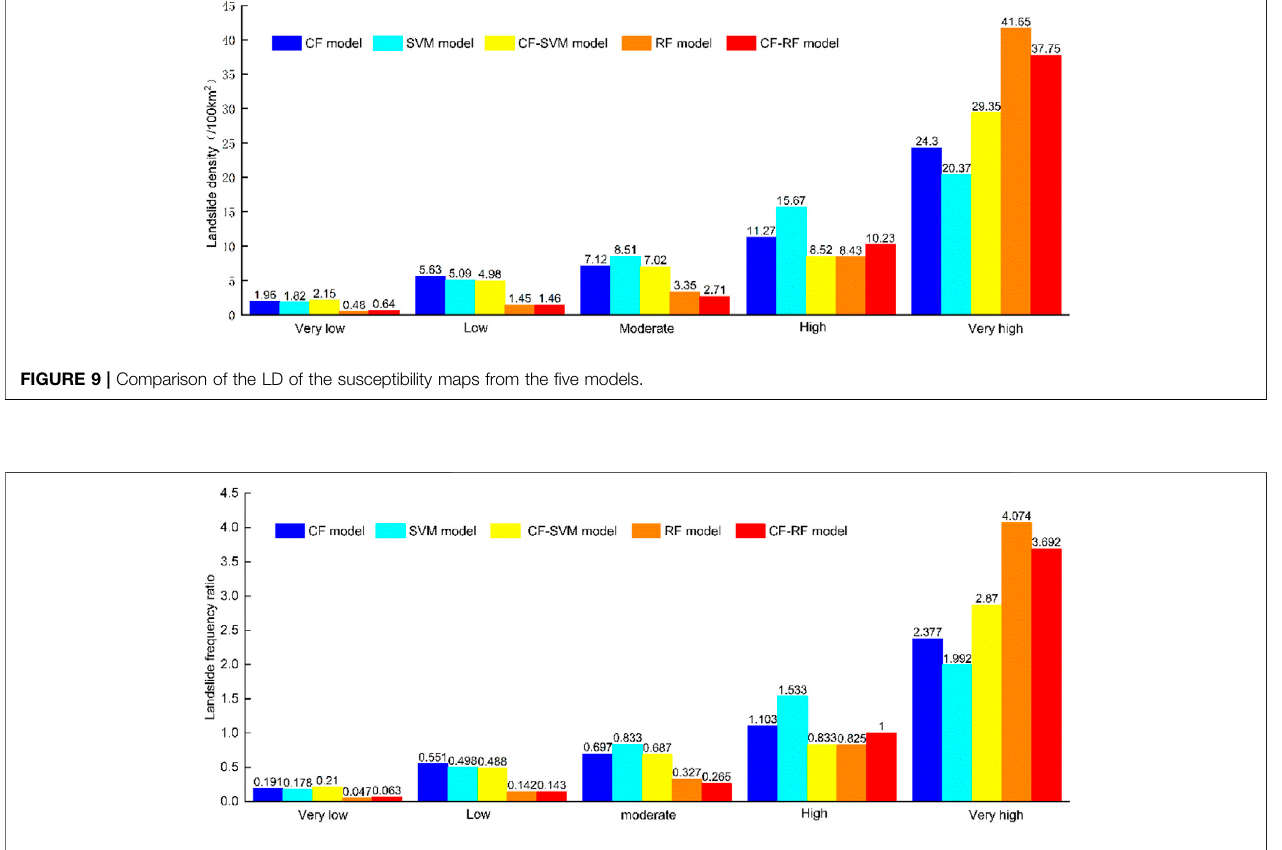
FIGURE 10 | Comparison of the FR of the susceptibility maps from fi ve